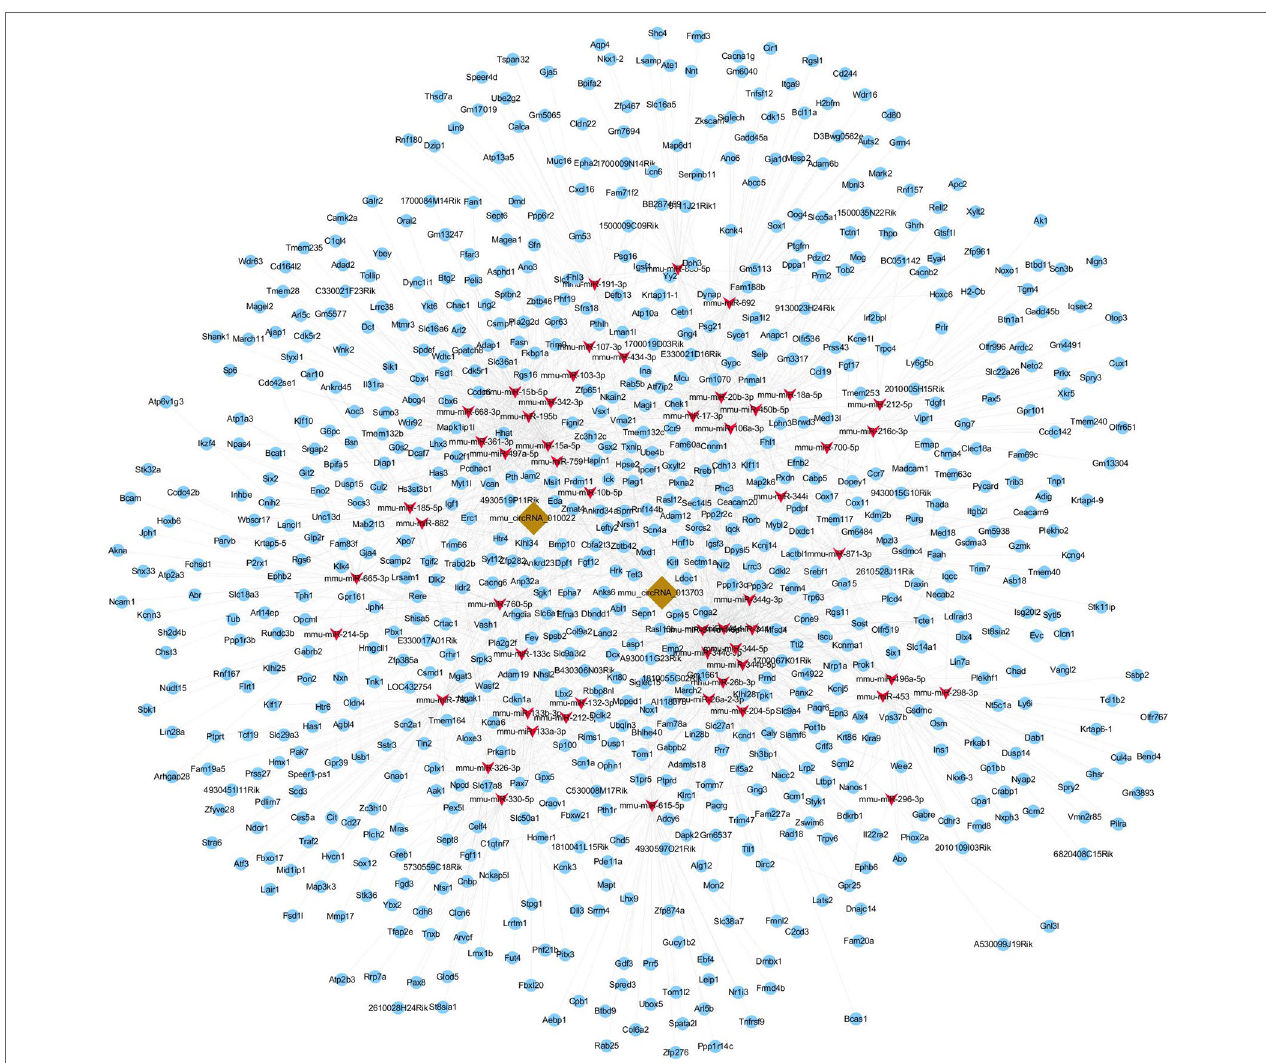
FIGURE 8 | circRNA-miRNA-mRNA co-expression network. The co-expression network was constructed by Cytoscape software based on conjoint analysis of circRNA and mRNA microarray results. Red nodes represent miRNAs, light-blue nodes represent mRNAs, and brown nodes represent circRNAs. The interconnected nodes represent direct